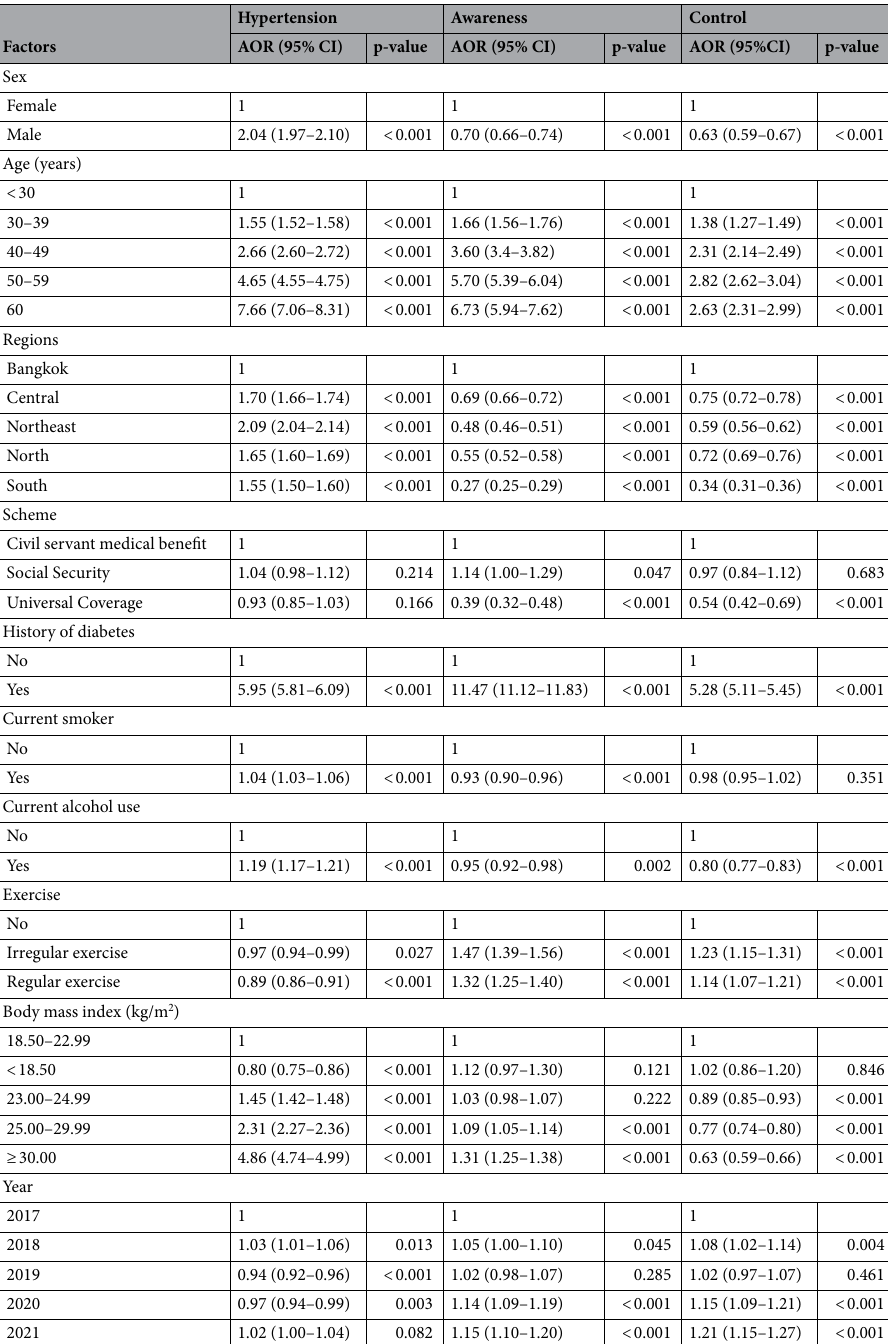
Table 5. Multivariable analysis for factors associated with prevalence, awareness, and control of hypertension (2017–2021). Adjusting for age, sex, regions, health insurance scheme, a history of diabetes, smoking status, alcohol use, exercise, body mass index, and years. AOR adjusted odds ratio, 95% CI 95% confidence